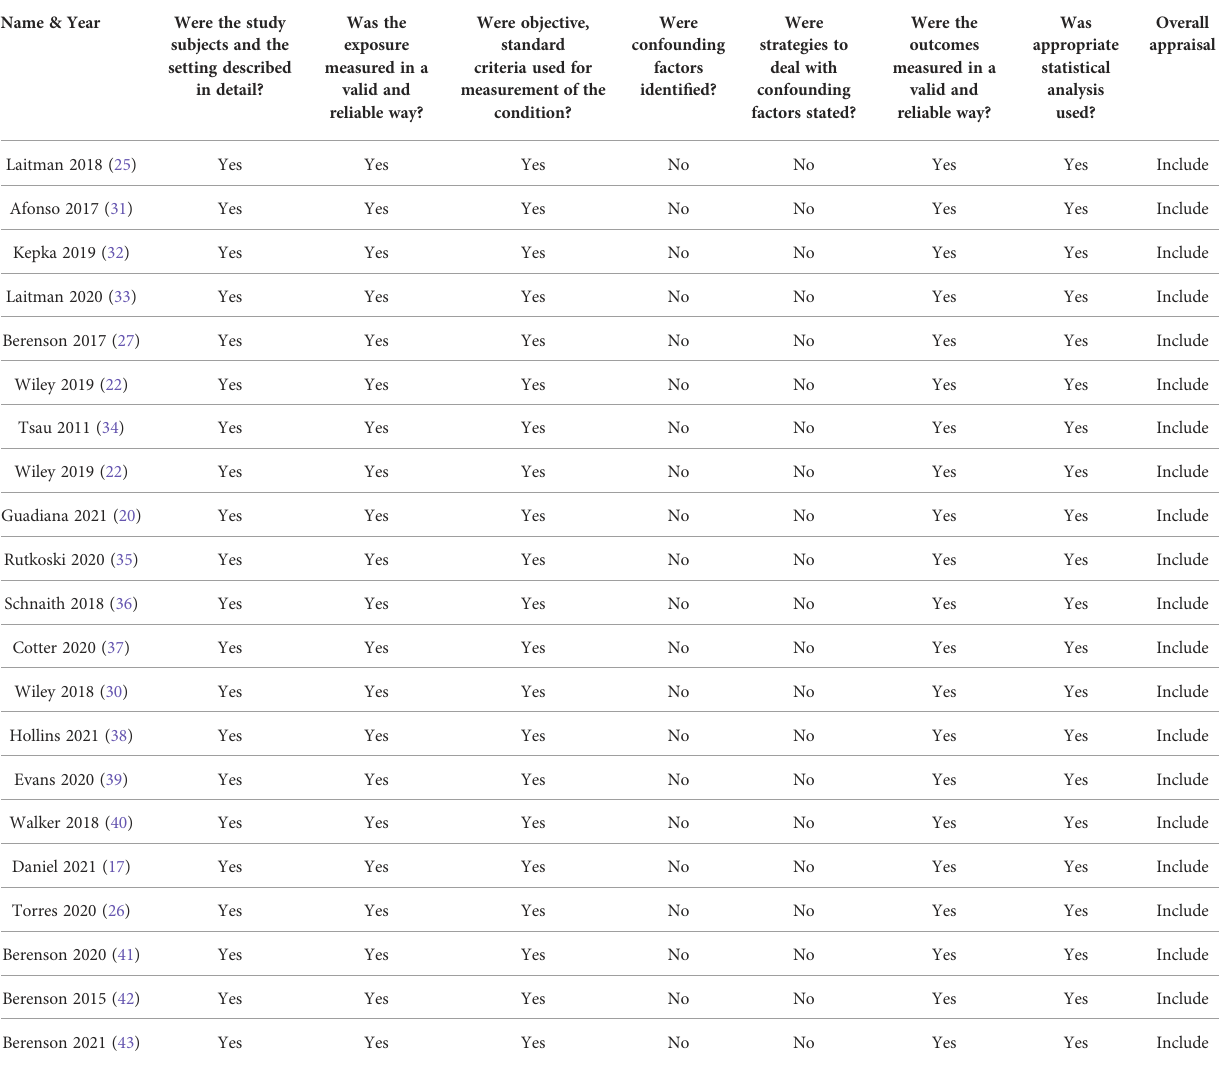
TABLE 2 Risk of Bias Evaluation